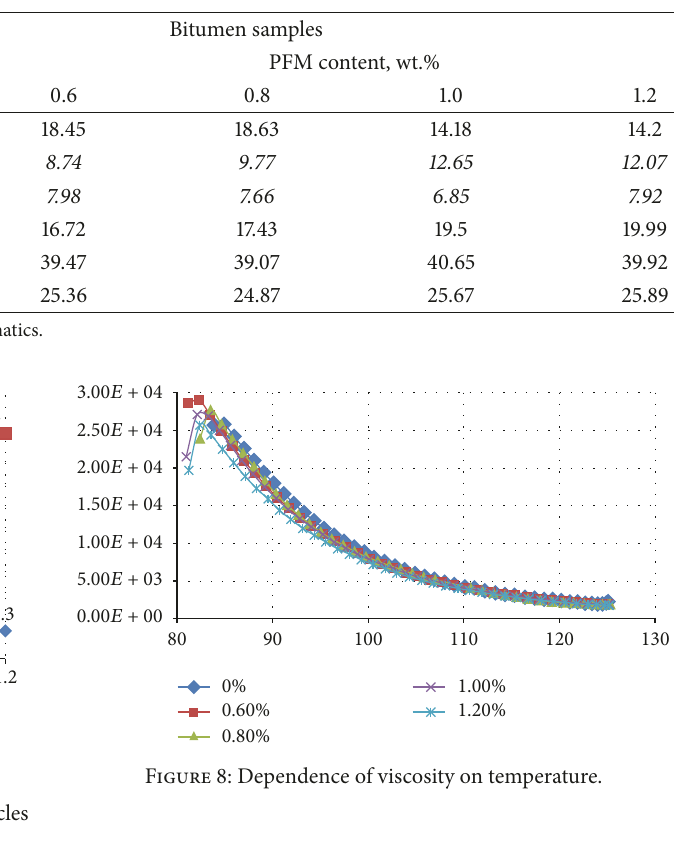
Table 9: Group chemical composition of the original and modified bitumen.